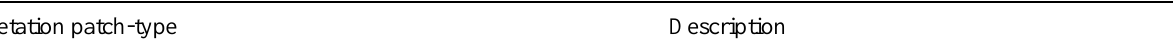
Table. 1 Classification of vegetation patch-types. Vegetation patch-type